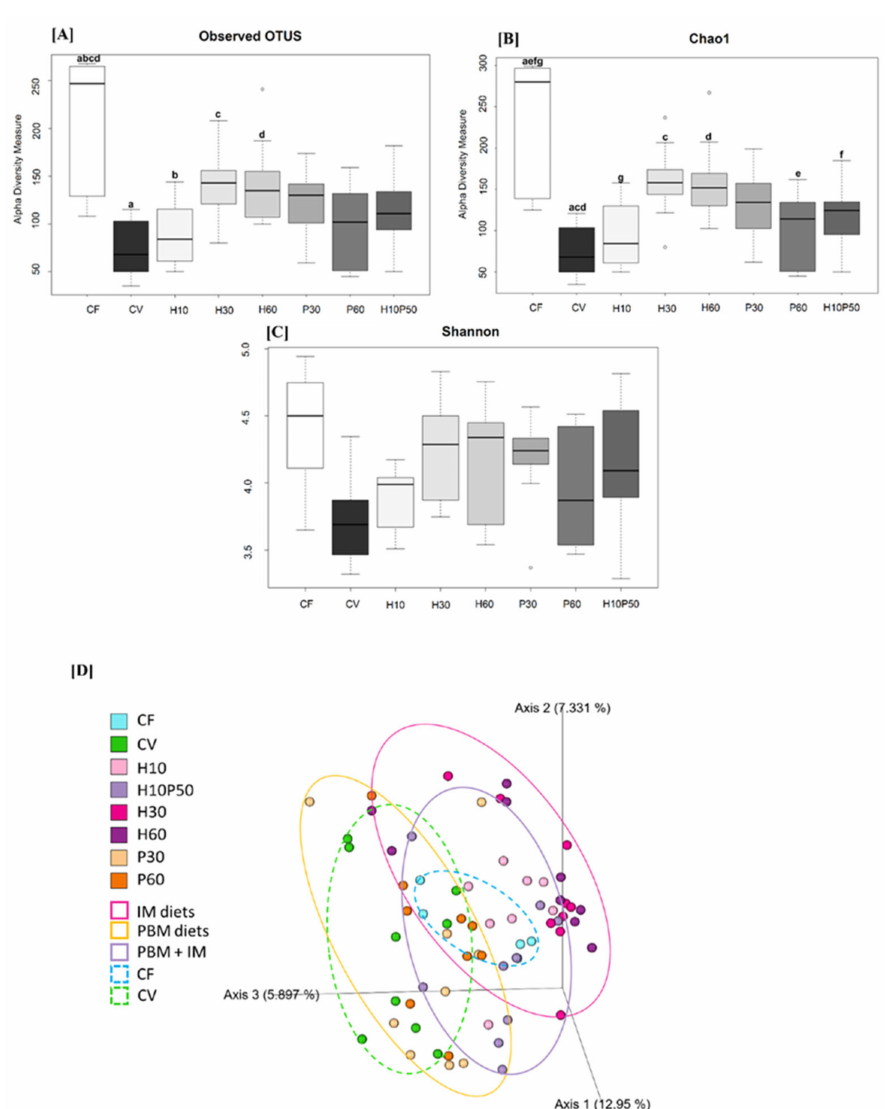
Figure 1. Intestinal bacterial α -diversity (Observed features ( A ), Chao1 ( B ) and Shannon index ( C )), and β -diversity (Unweighted Unifrac PCoA plot ( D )) in rainbow trout fed fish-meal (CF), vegetable meal (CV), increasing percentage of Hermetia illucens insect meal (H10, H30, H60), increasing percent- age of poultry by-product meal (P30, P60), and a combination of insect meal and poultry by product meal (H10P50) ( n = nine fish per group). Within each panel, identical superscript letters indicate statistically significant differences (FDR p <